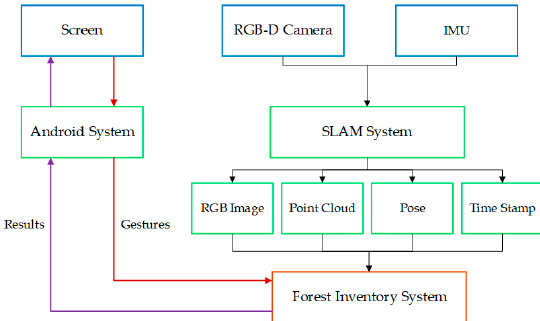
Figure 4. The workflow of our system.